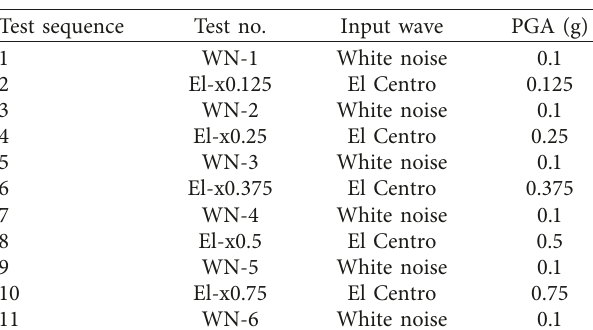
–0.3–0.2–0.100.1